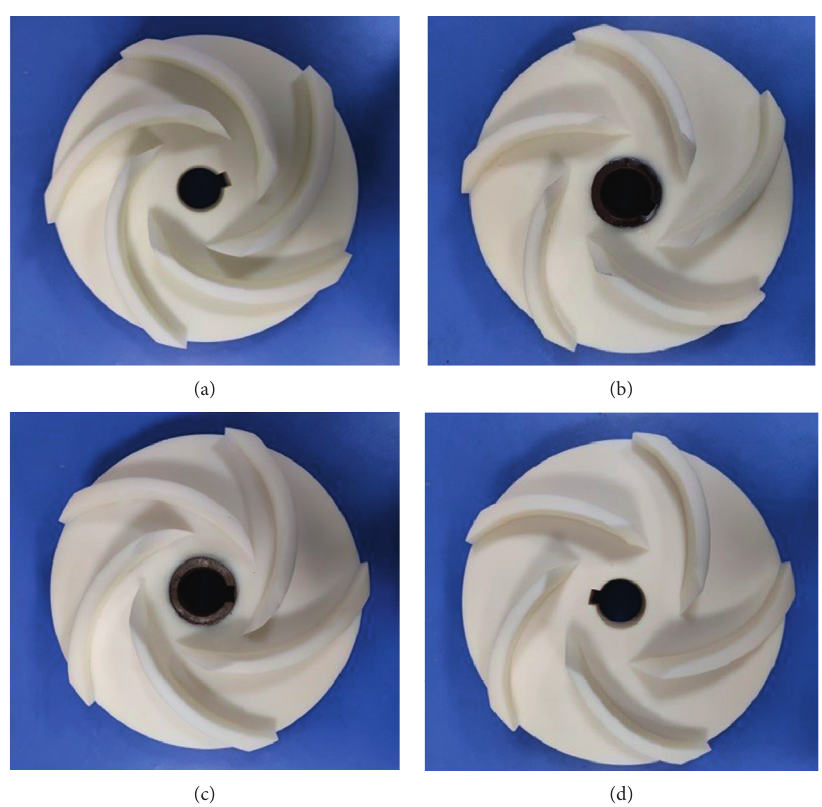
Figure 11: 3D printing of impellers. (a) Single arc. (b) Double arc. (c) Logarithmic spiral. (d) B-spline curve.